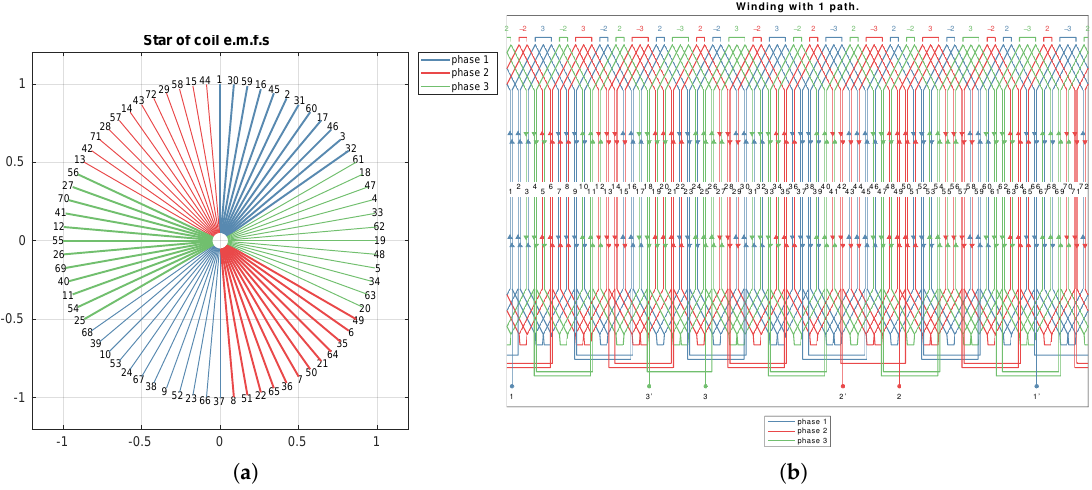
Figure 14. Three-phase symmetrical winding with N = 72, p = 5, m = 3 and q = 2 + 2 / 5 . ( a ) Star of slots and ( b ) winding